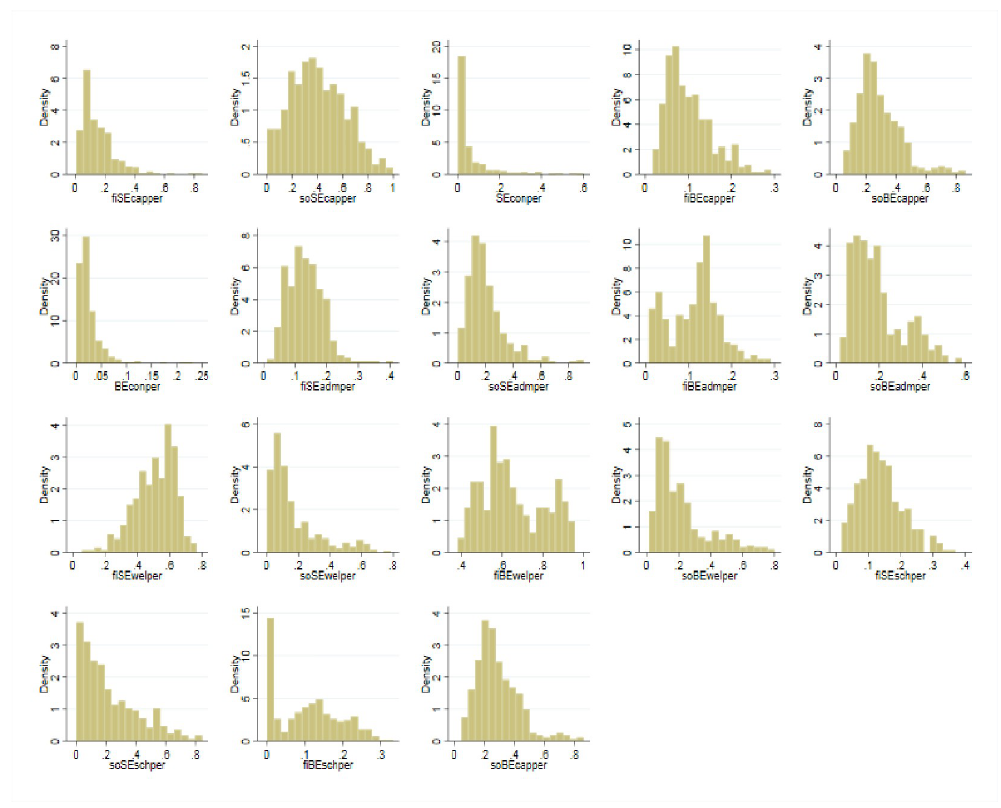
Fig 11. The density distribution of each kinds of expenditures by different social sectors. Data source are China Education Statistics Yearbook , Statistical Yearbook of China’s Educational Expenditure . Drawn by STATA